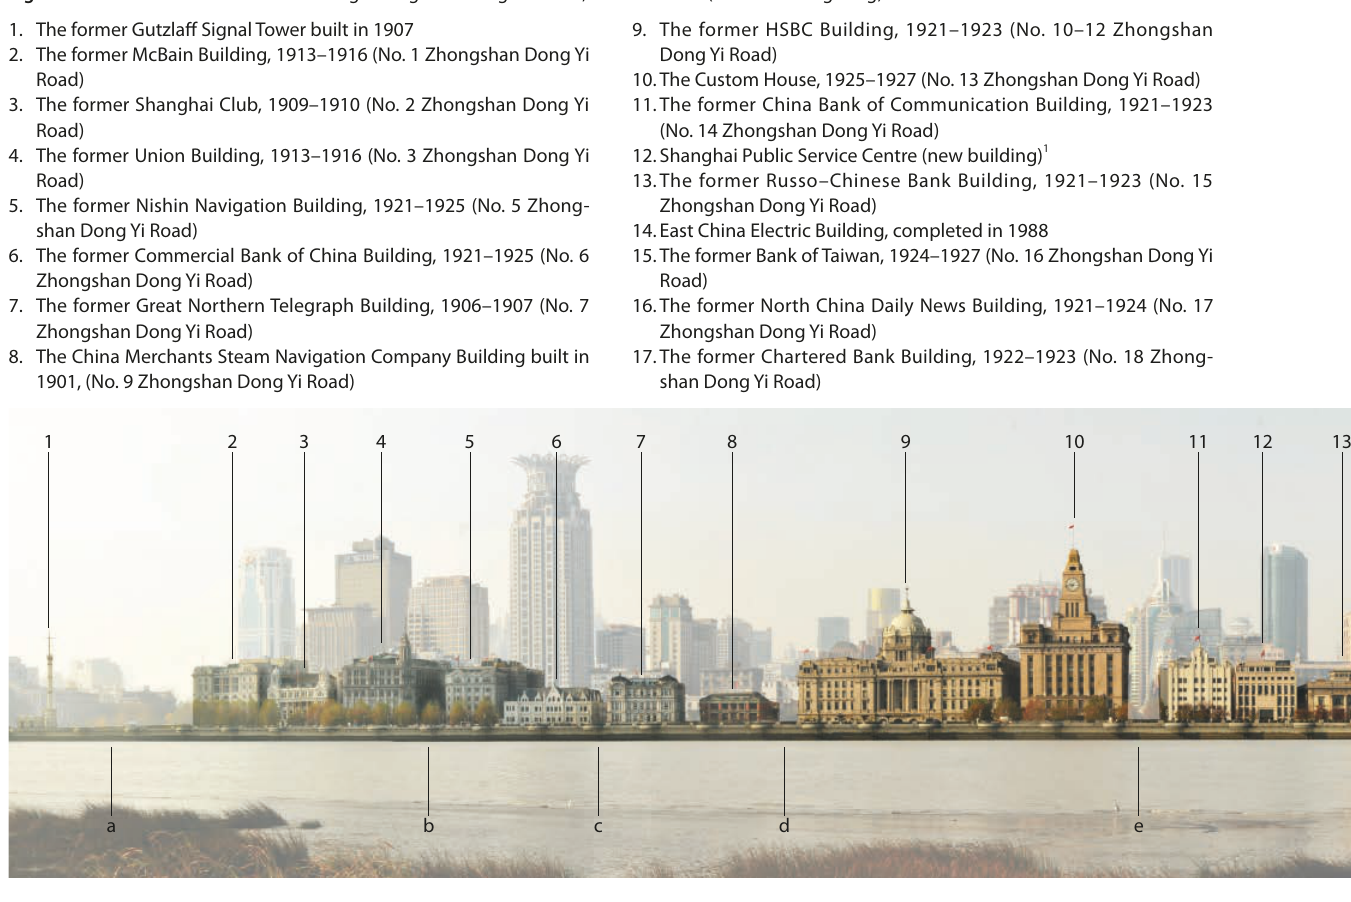
Figure 8 Panorama of the historic buildings along the Shanghai Bund, taken in 2019 (Source: Zhong